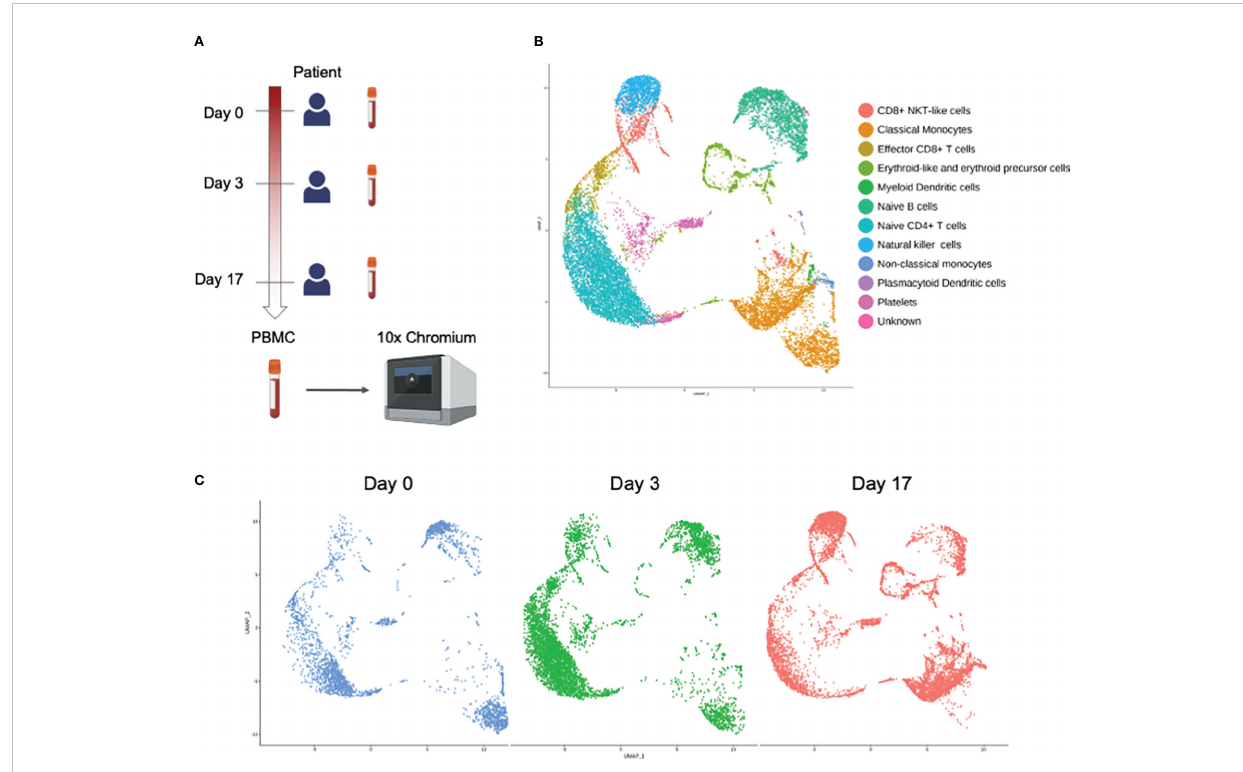
FIGURE 2 Single-cell RNA-seq analysis of PBMCs obtained at day 0, day 3, and day 17 from the patient. (A) Experimental design of the study. Figure was created using BioRender.com. (B) UMAP projection of all PBMCs with major subsets annotated. (C) UMAP projection of all PBMCs split by samples.